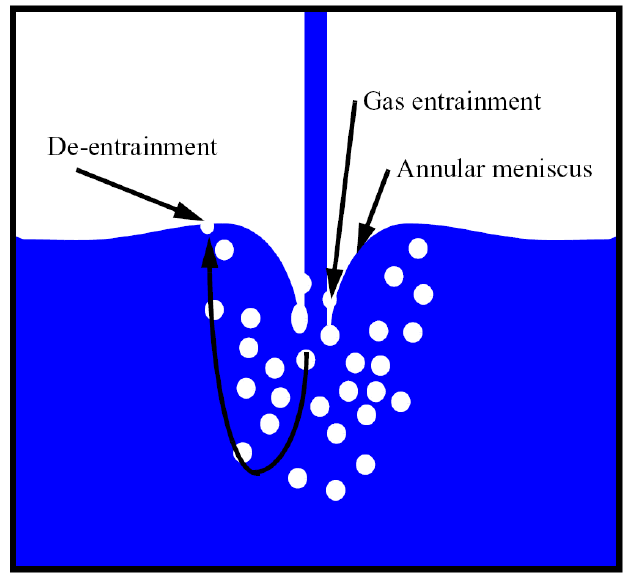
Figure 8. Gas entrainment caused by a plunging jet